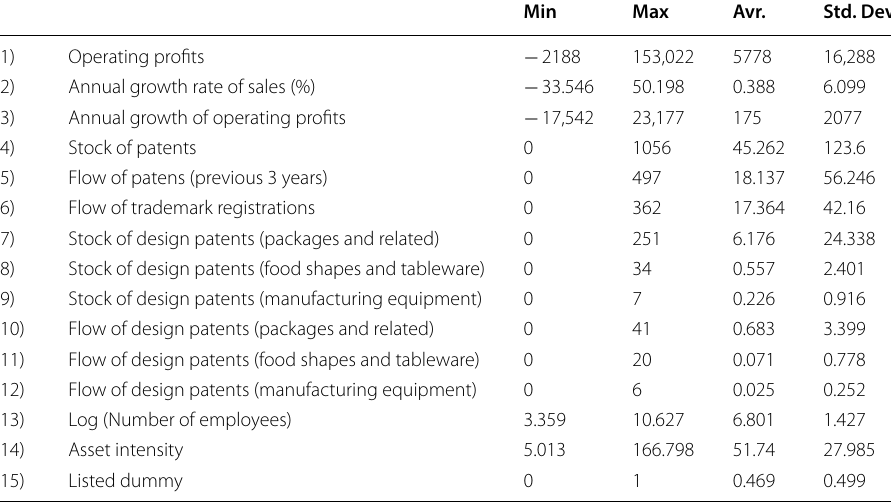
Table 2 Fundamental statistics of the